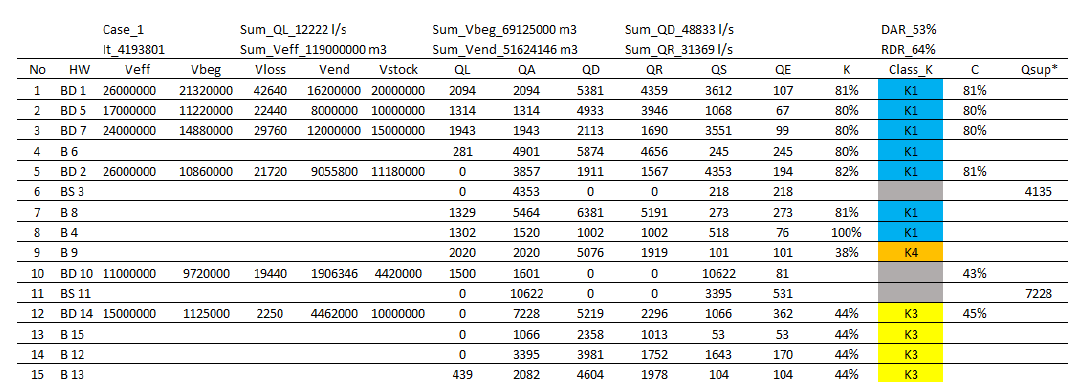
Figure 10. Some network equation tables for optimization-simulation.